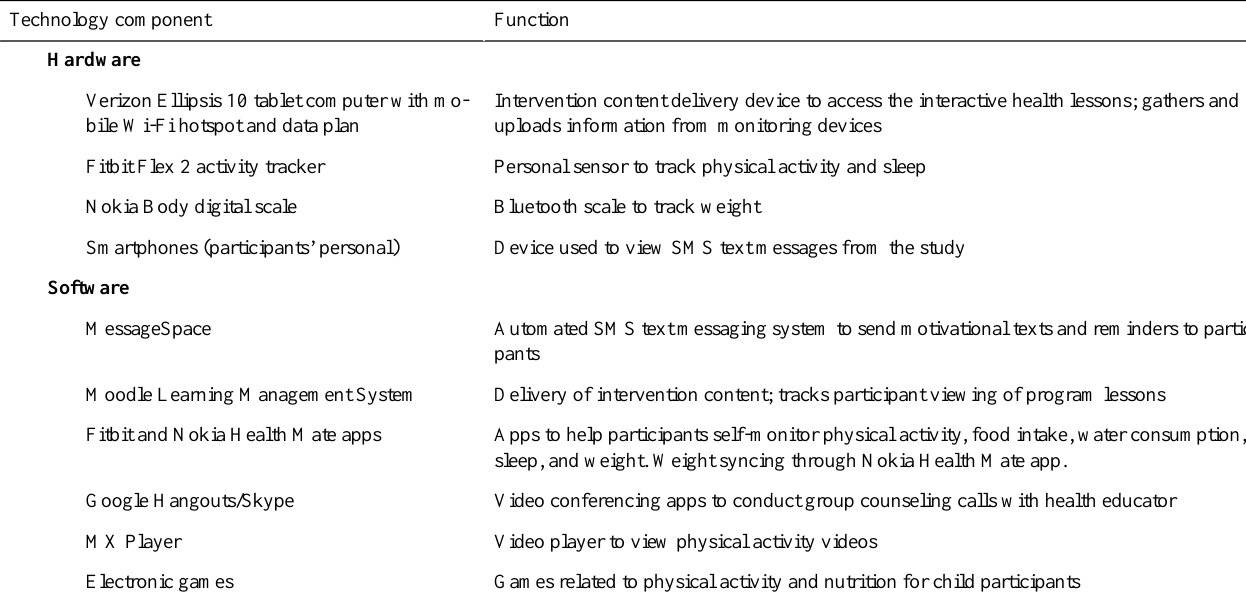
Table 3. Technology components and functions used by remote technology intervention.